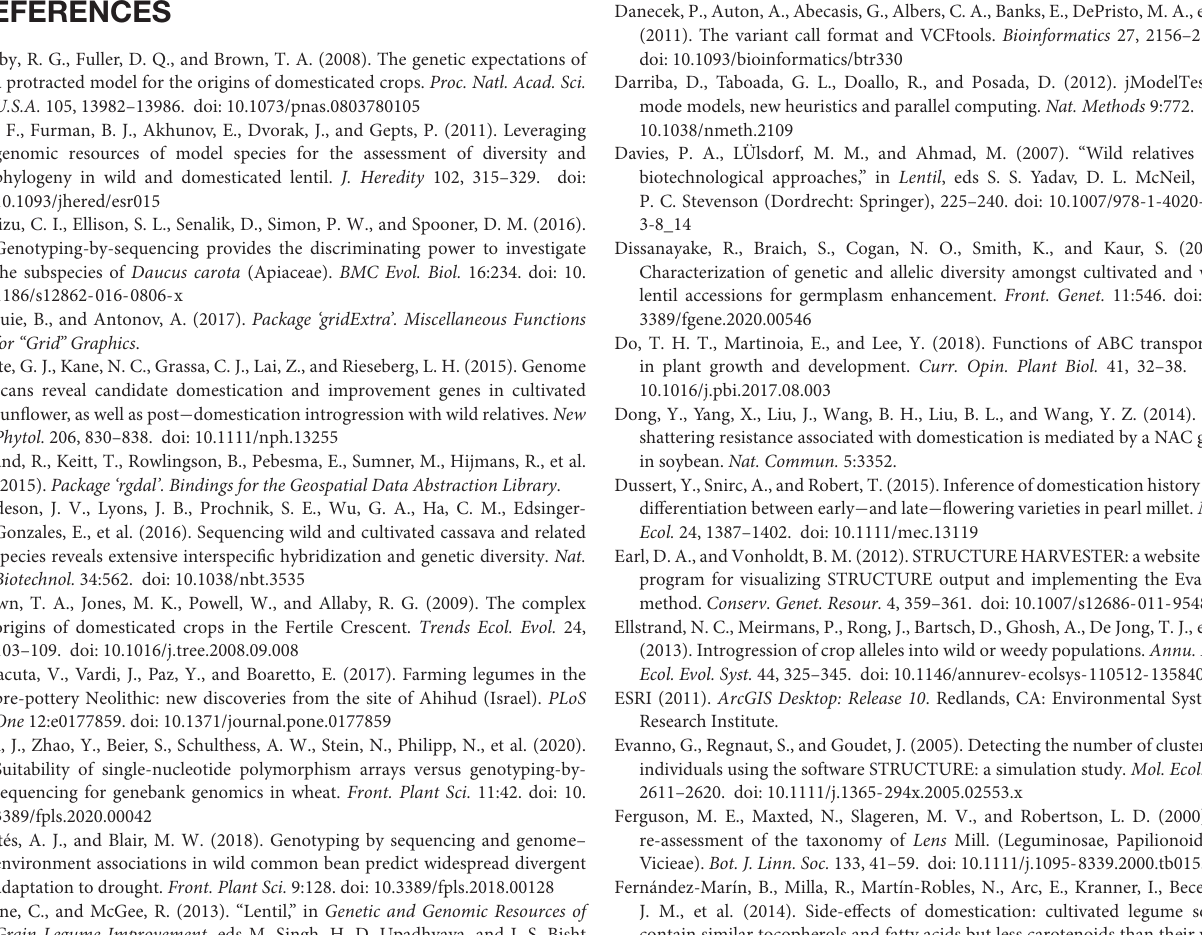
Supplementary Figure 13 | Phylogeny of 190 accessions of Lens produced using the GTR + (cid:48) substitution model with different rooting taxa. (A) Inferred